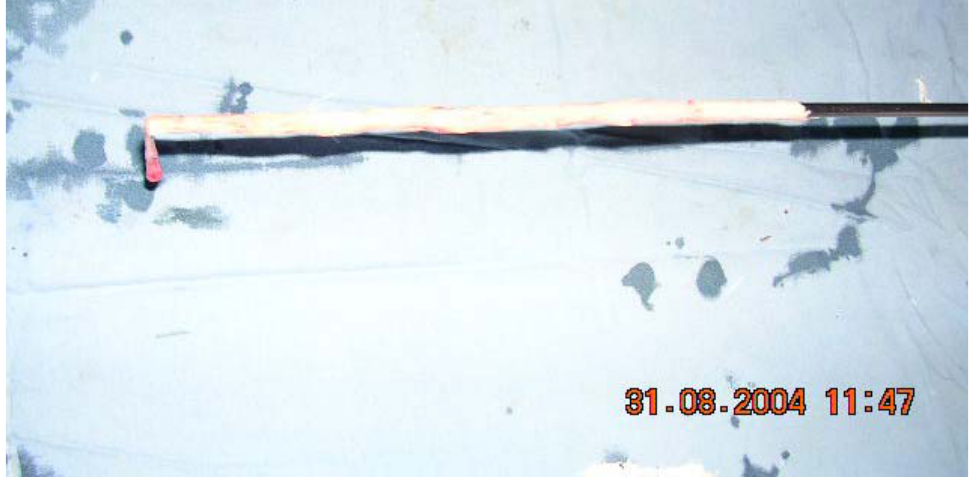
FIGURE 2 . Complete avulsion of